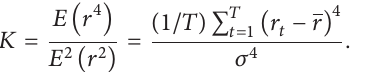
Each frequency band contains different frequency compo- nents and may vary with the change of the vibration signal 𝑥(𝑡)